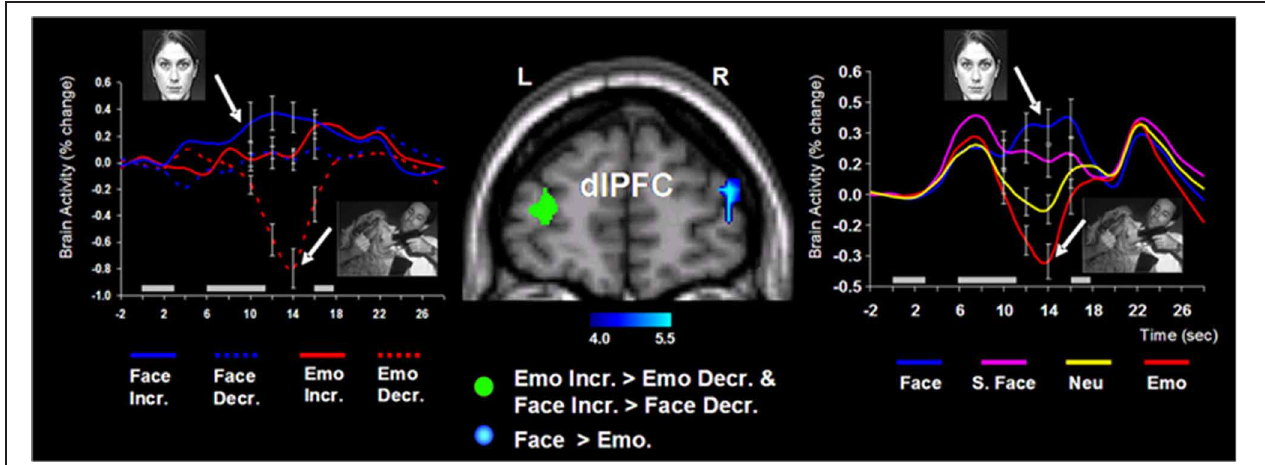
FIGURE 4 | Opposing dorsolateral prefrontal cortex (dlPFC) modulation linked to the nature of distraction. Specific areas of the right dlPFC (e.g., BA 10/46) showed opposing modulation linked to the nature of distraction (i.e., in creased activity to memoranda-confusable face distracters, and de creased activity to emotional scene distracters). These findings were also confirmed when faces and emotional scene distracters were compared to their corresponding control conditions (i.e., scrambled faces and neutral scene distracters, respectively). The blue cluster on the middle panel shows the activation map of the direct contrast between delay activity to face and emotional distracters, superimposed on a high-resolution brain image displayed in a coronal view. The colored horizontal bar at the bottom of the brain image indicates the gradient of the t values. The line graph on the right side shows the time courses of activity in the right dlPFC region of interest (ROI). As described in section II below, specific dlPFC areas in the left hemisphere (i.e., the green cluster